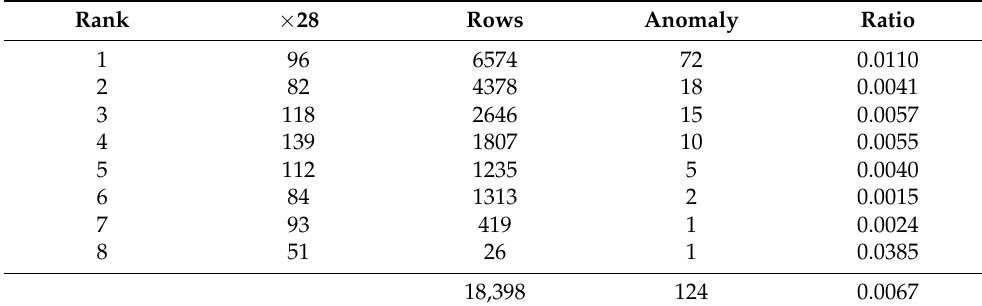
Figure 2. Original multivariate time series (6 variables selected) from manufacturing process. The data collected by the sensors are multivariate time series. There are 18,398 rows and 62 columns. There are 61 variables and two of them are categorical variables. The categorical variable × 28 stands for the paper grade. The dataset is extremely imbalanced data since the ratio of positive data is 0.67%. Statistically, if an event constitutes less than 5% of the dataset, it is categorized as a rare event. In this case study, the breaks which occur at less than 1% are discussed and modeled. The basic description of the spilt data samples is in Table 2. The variable × 28 has eight categorical numbers which stand for different paper grades. The total failures amount to 124. Table 2. The statistics of original dataset.